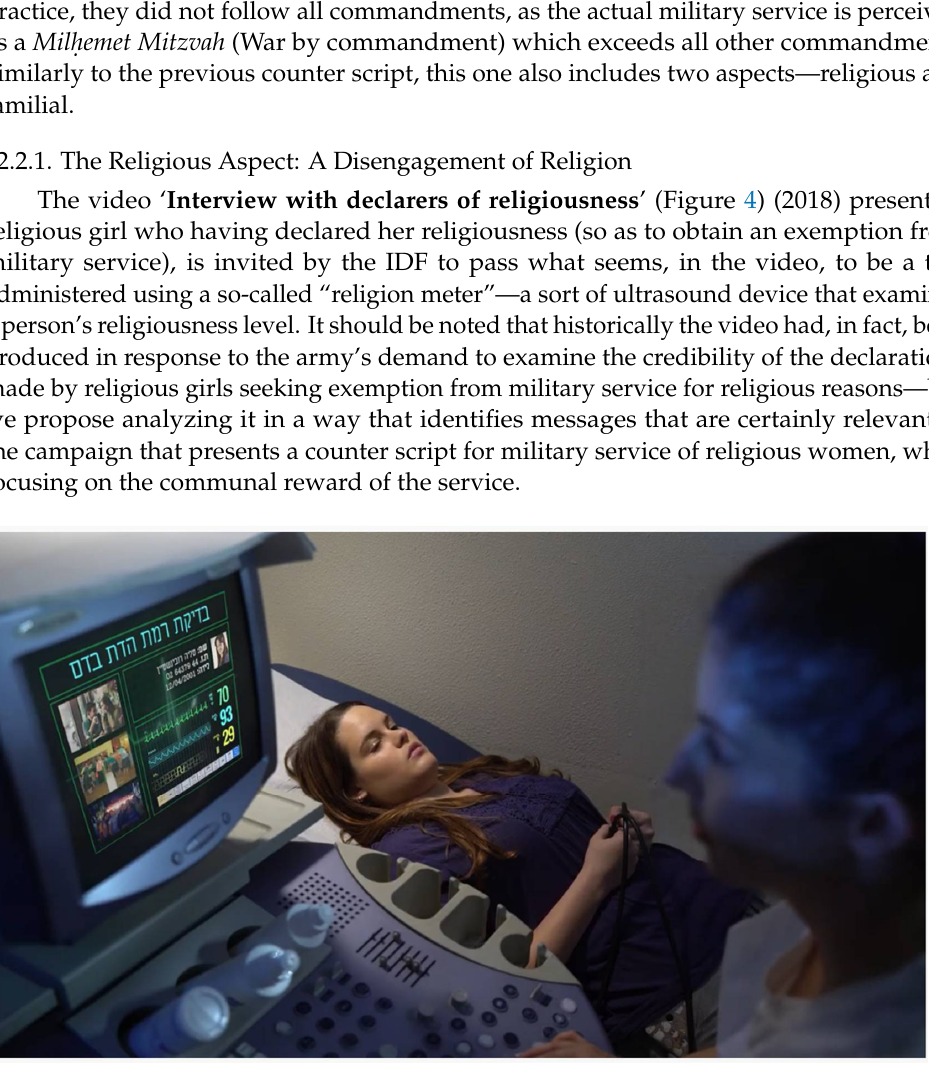
Figure 4. ‘Interview with declarers of religiousness’ (April 2018). [Hebrew wording on the monitor: “Test for level of religiousness in the blood”] (Supplementary Materials).